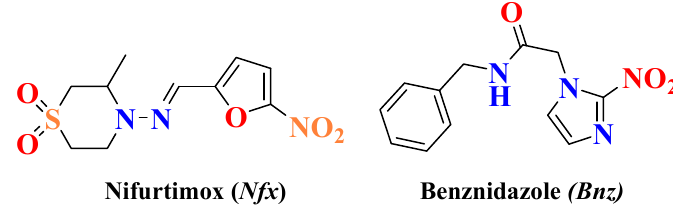
Figure 1. Main antichagasic chemotherapeutic agents.